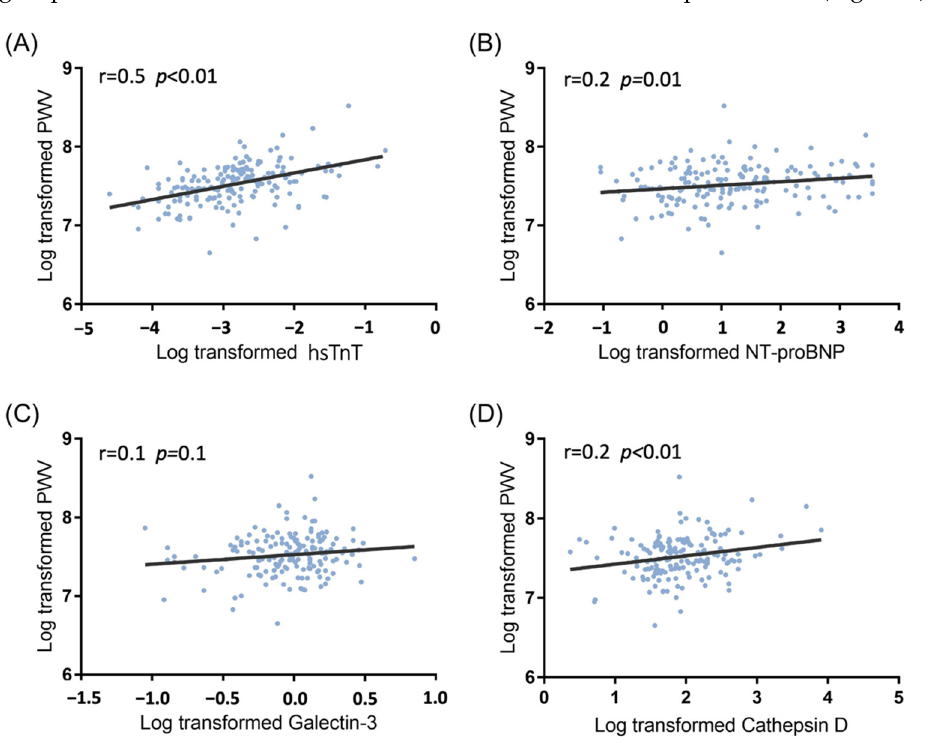
Figure 3. The mean values of CV biomarkers in quartile groups of brachial–ankle pulse wave veloc- ity among hemodialysis patients: ( A ) high-sensitivity troponin T ( p for trend < 0.01); ( B ) N-terminal pro-brain natriuretic peptide ( p for trend 0.01); ( C ) Galectin 3 ( p for trend = 0.12); ( D ) Cathepsin D ( p for trend = 0.02). Multiple comparisons were performed by Dunn’s multiple comparison test (a.